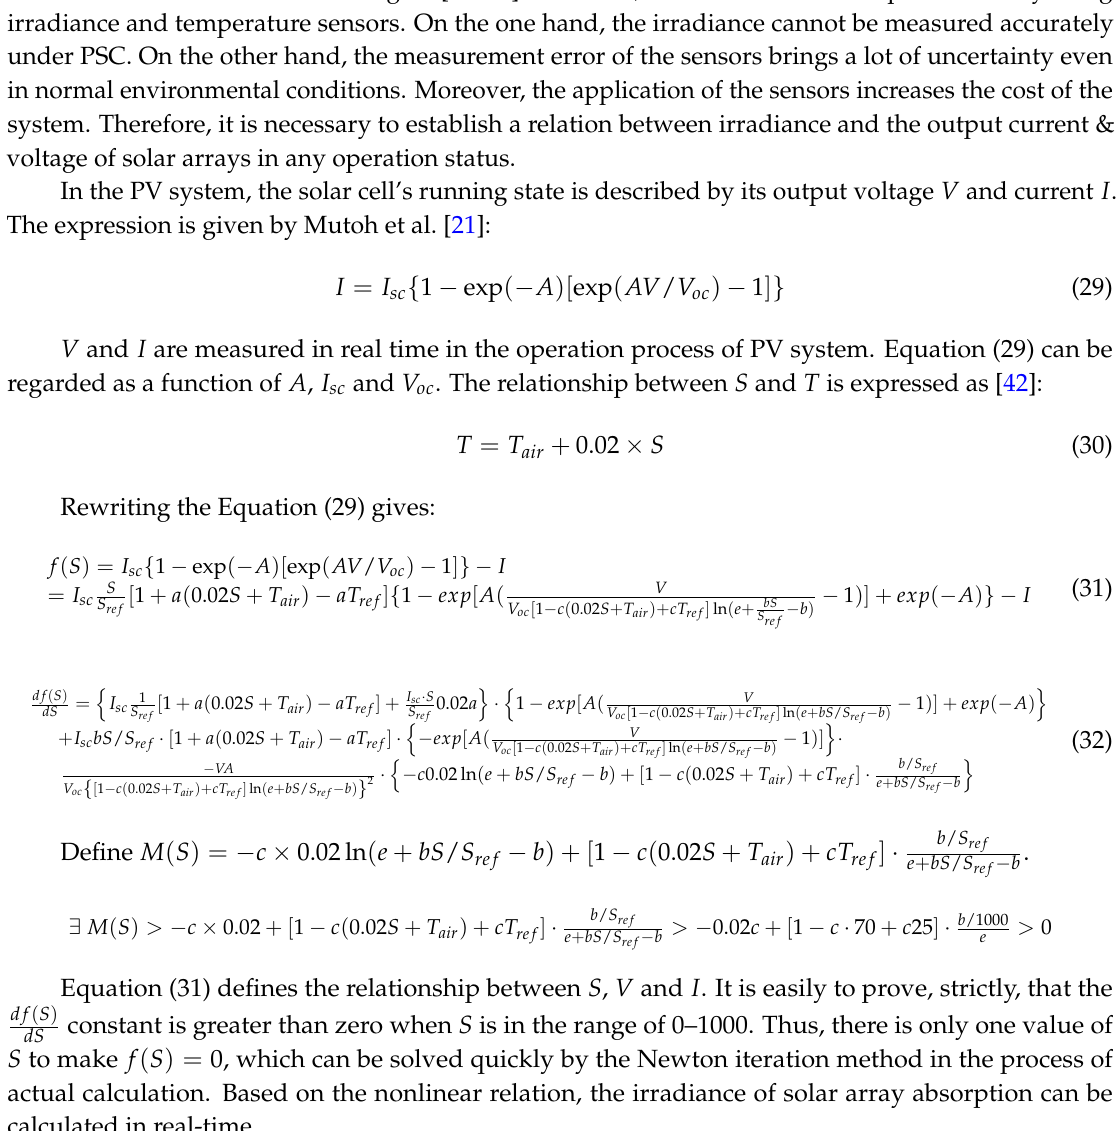
Table 2. Typical values of L q